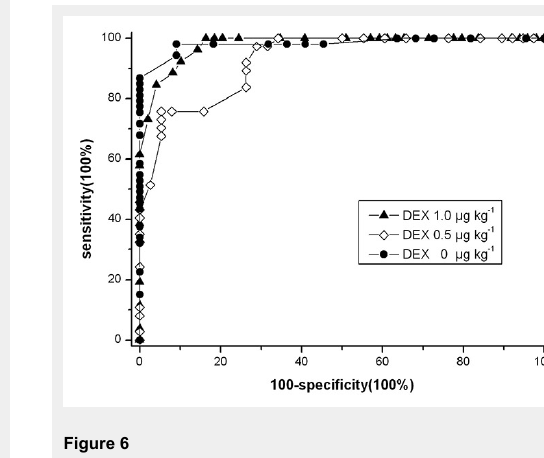
The relationship between the probability of loss of consciousness (LOC) and the propofol effect-site concentration. (DEX = dexmedetomidine.)